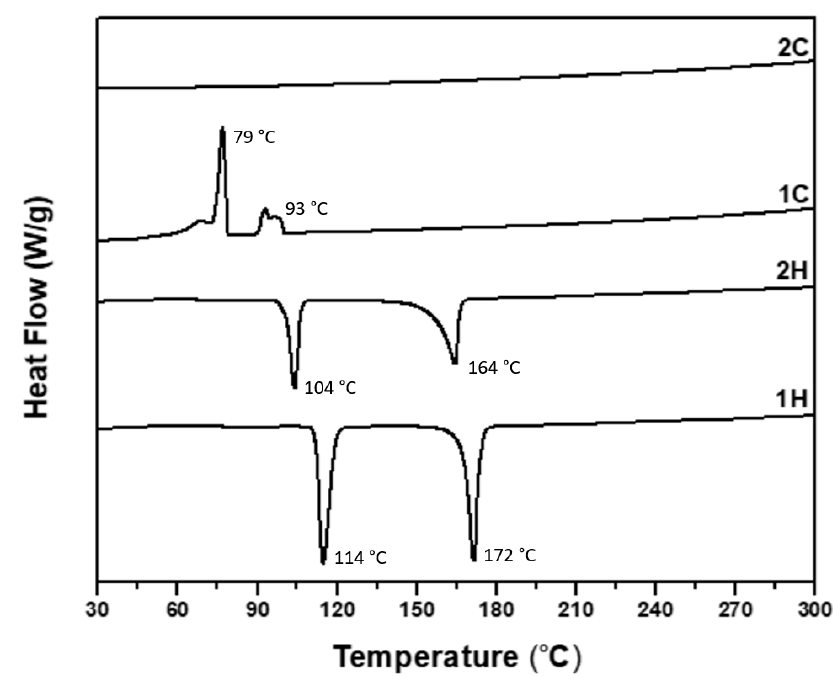
Figure 2. Di ff erential scanning calorimetry (DSC) thermograms of EV1 obtained at heating and cooling Figure 2. Differential scanning calorimetry (DSC) thermograms of EV1 obtained at heating and rates of 10 ◦ C / cooling rates of 10 °C /min.